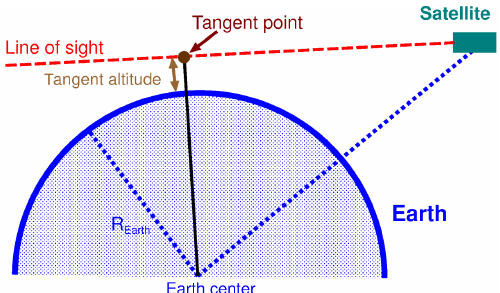
Figure 1. Schematic of the geometry of satellite limb observations. The satellite instrument views toward the Earth’s horizon. The point of the instruments’ line of sight closest to the Earth’s surface is called the tangent point, and the corresponding altitude is the tan- gent